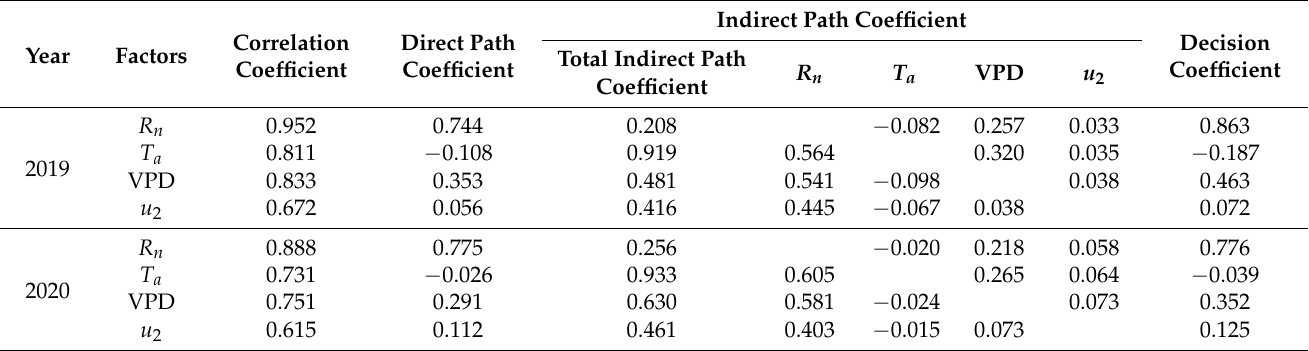
Table 1. Path analysis results of ET, net radiation R n , air temperature T a , vapor pressure deficit VPD and 2 m high wind speed u 2 of greenhouse tomato under drip